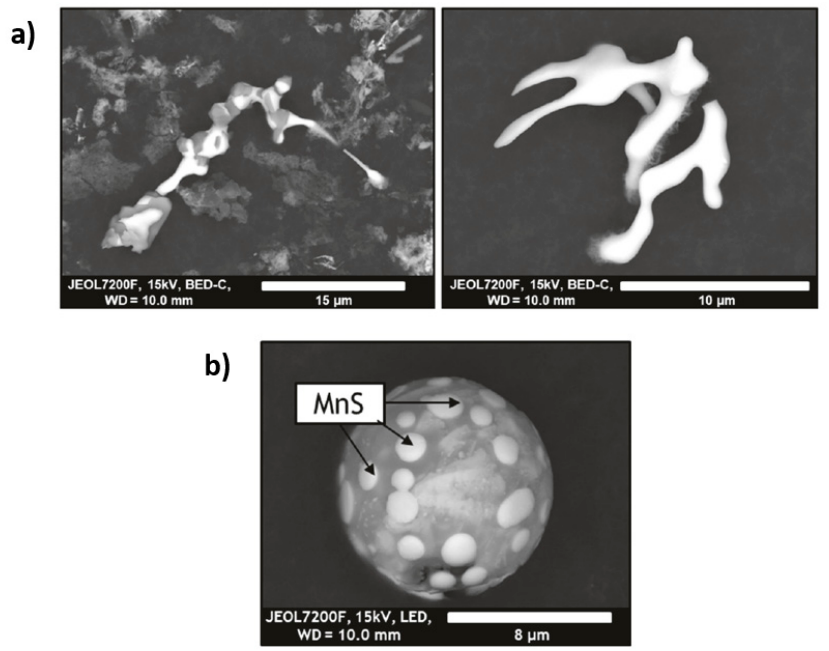
Figure 2. SEM images of ( a ) irregular shaped sulphide inclusions extracted from a plain carbon steel and ( b ) oxide inclusions with sulphide regions as extracted from low carbon high strength grade. The sulphides were extracted using the sequential chemical extraction using the 5% Nital. Adapted from the Ph.D thesis of Alexander Mayerhofer [11].